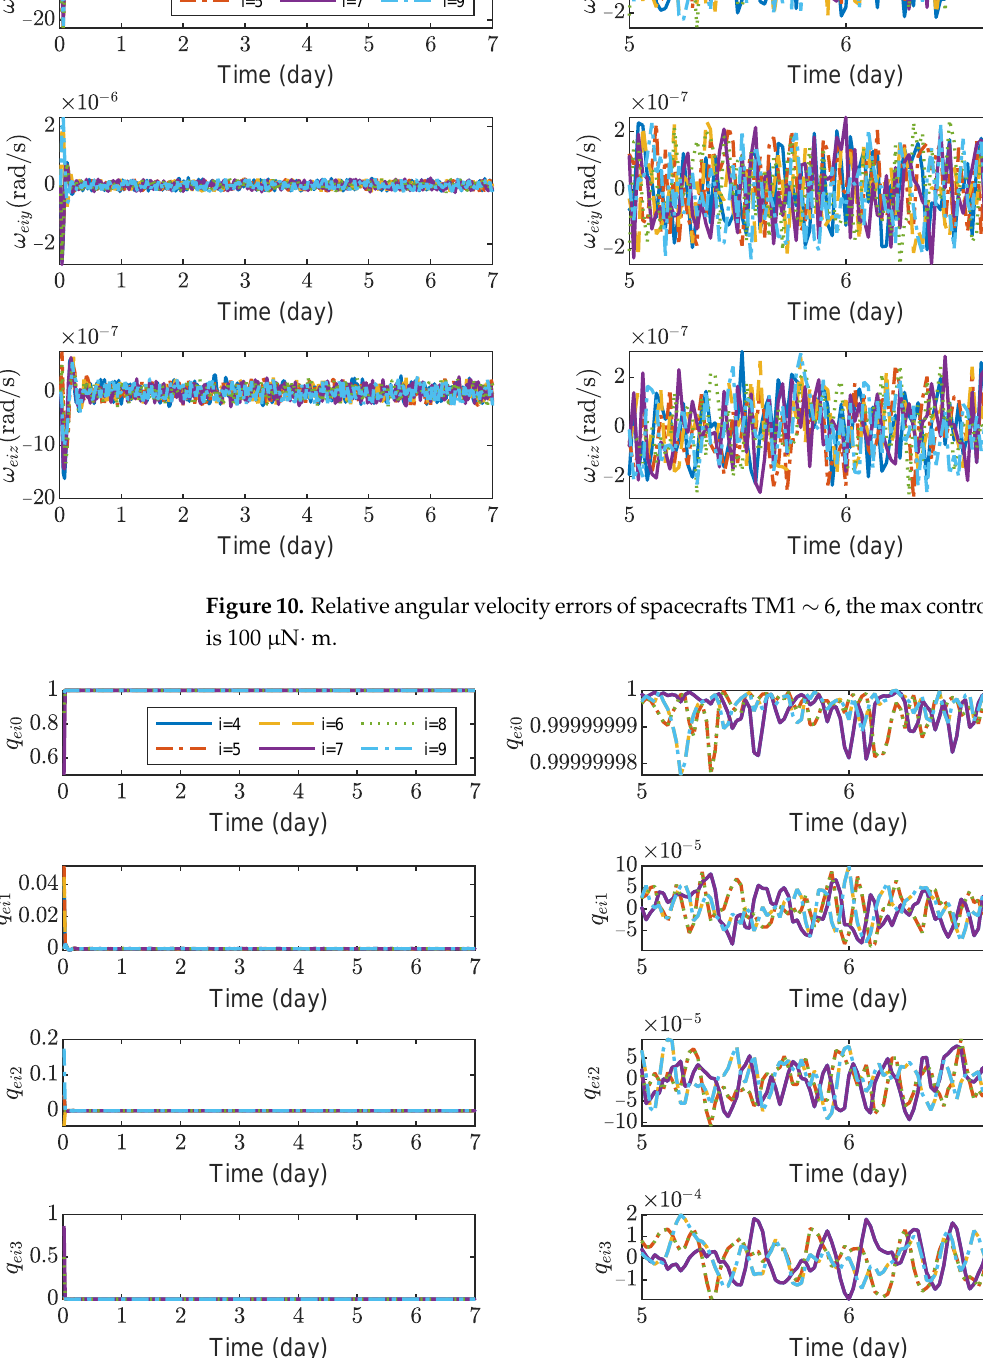
Figure 11. Relative attitude errors of spacecrafts TM1 ∼ 6, the max control torque of spacecraft is 100 µ N ·